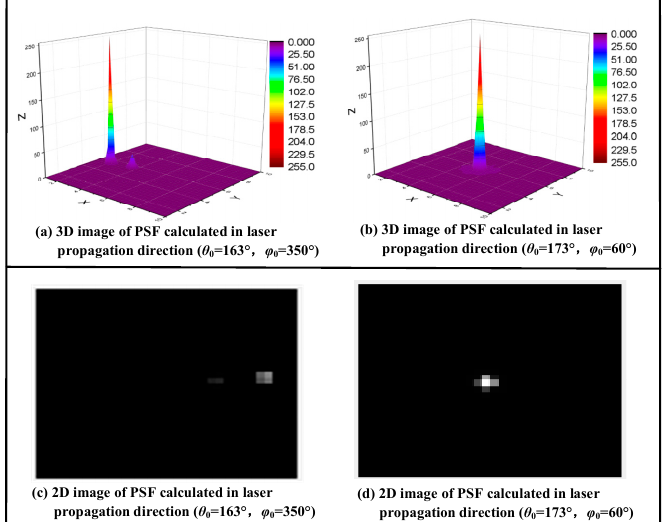
Figure 2. Atmospheric modulation patterns for two different propagation paths. The propagating direction was determined by the zenith and azimuth angles: ( a , b ) are the 3D images, ( c , d ) are the corresponding 2D images (modulation patterns).